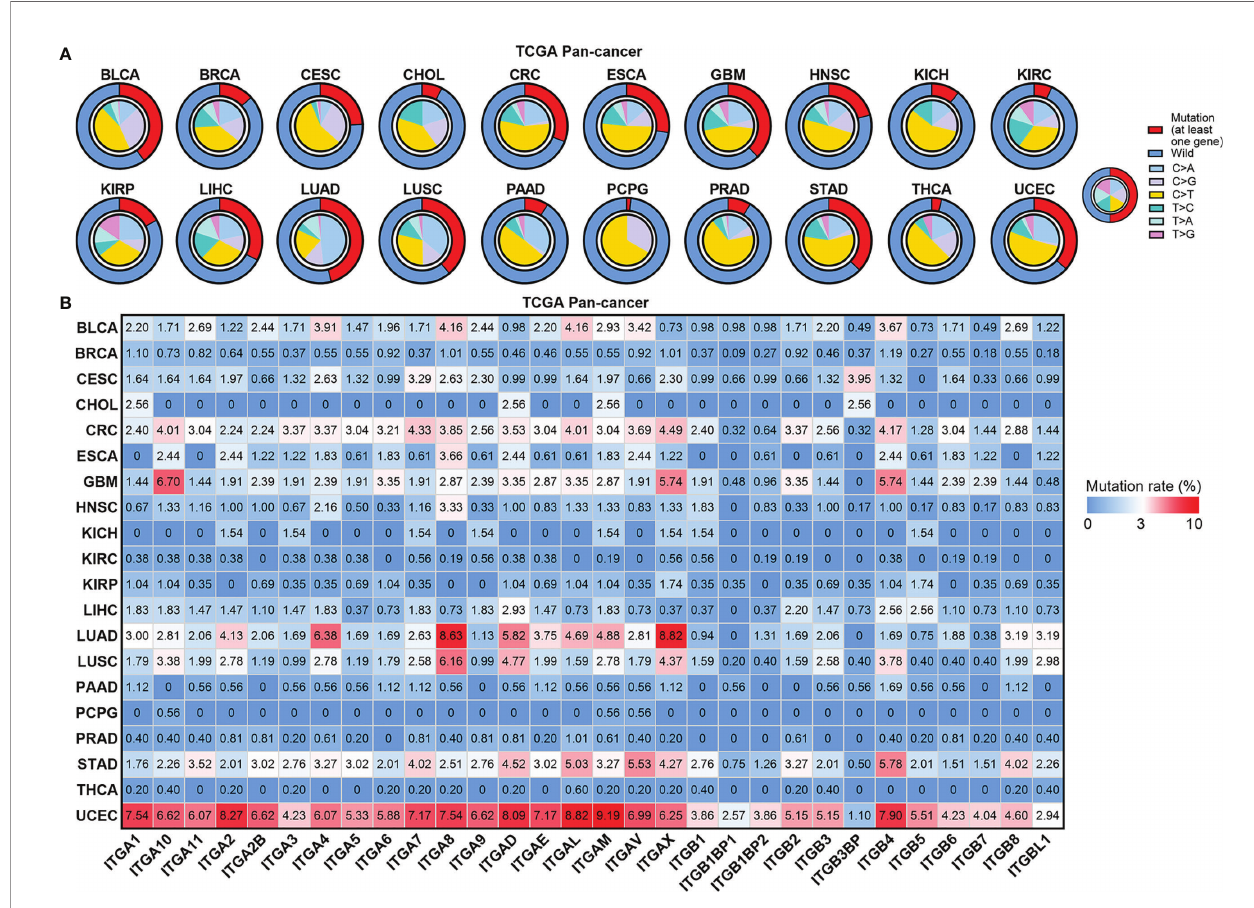
FIGURE 3 | Mutation landscape of ITGs in human cancers. (A) Small pie charts showing the proportion of the six transition and transversion categories for each cancer type. Cycle showing the mutation rates (at least one gene mutant in this sample) for each cancer type. (B) Heatmap showing mutation rate of each ITG in human